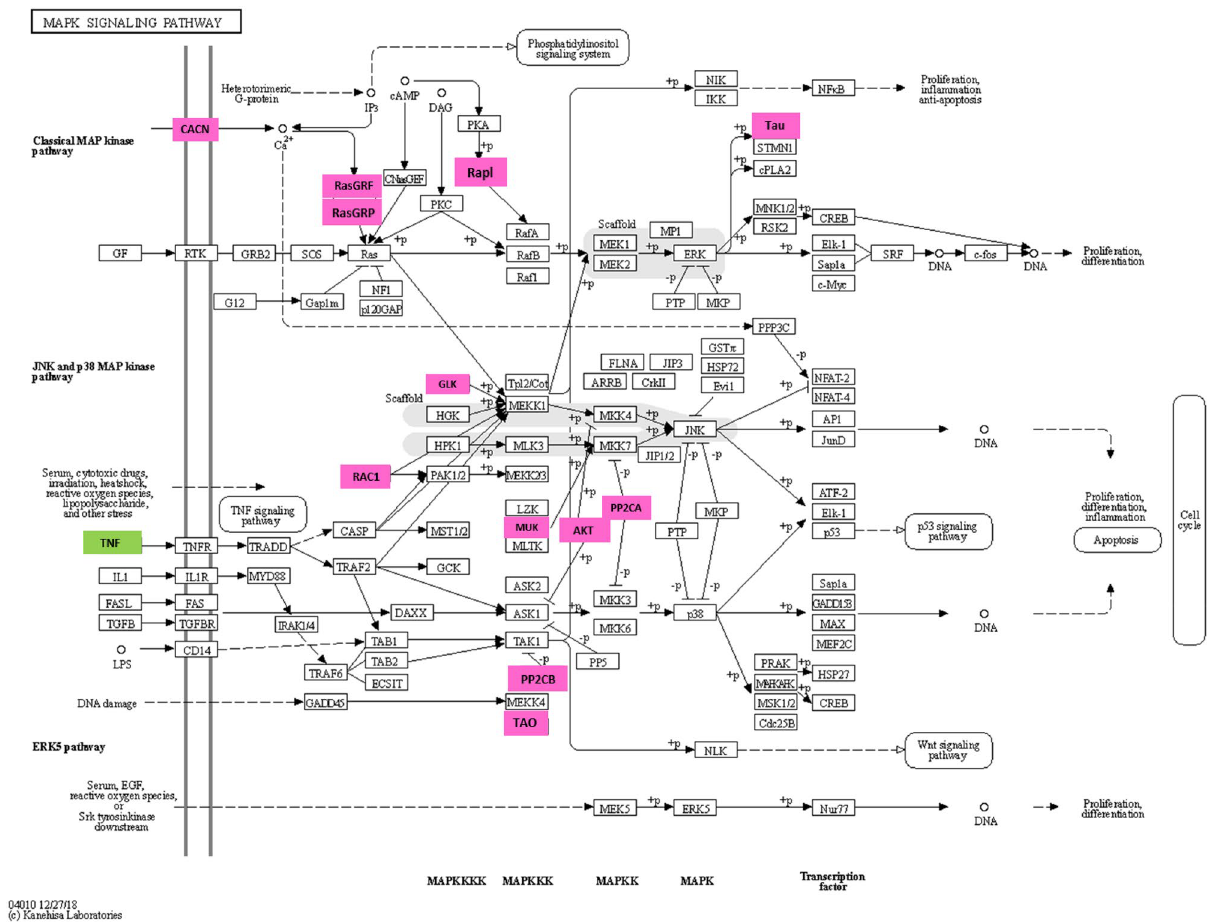
Figure 9. MAPK signaling pathway. Green box: tumor necrosis factor-alpha. Pink boxes: downregulated proteins in the HFLac